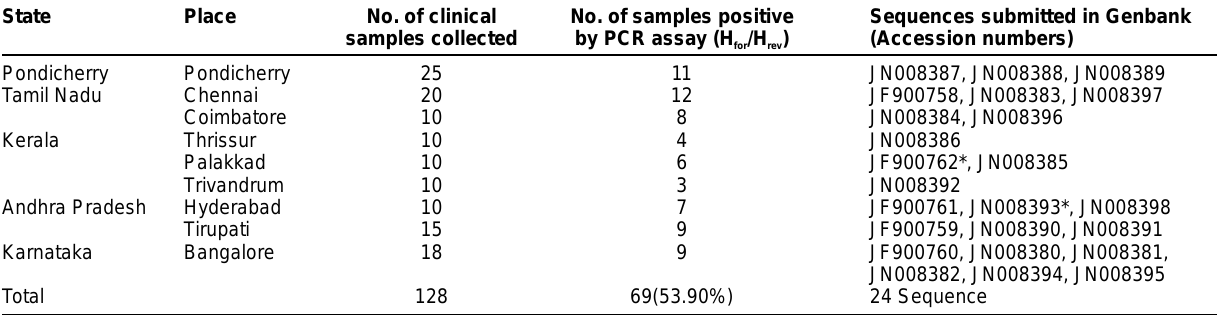
Table-1. Details of occurrence of CPV based on location (southern India) State